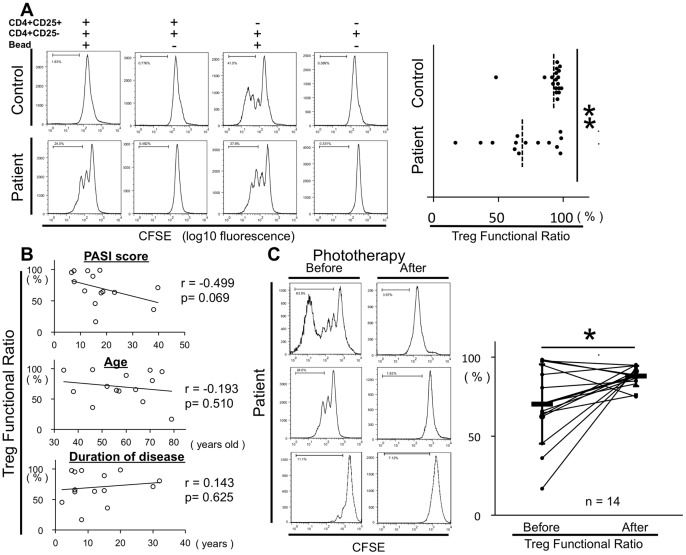
Photo(chemo)therapy restores dysfunctional Treg in patients with psoriasis.(A) CD4+T cells were separated with magnetic beads as CD25+T cells or CD25− T cells. CD4+ CD25− T cells were labeled with CFSE, and activated with anti-CD3, CD28 beads for 4 days, with or without CD4+ CD25+T cells (Treg) (CD4+ CD25− T cells : CD4+ CD25+T cells = 2×105 : 1×103). FACS data for a typical patient and control are presented. Cells were gated on CD4+T cells. Treg did not suppress CD4+ CD25− T cell proliferation in patients (lower panels) as effectively as in controls (upper panels). The ability of Treg to suppress the proliferation was referred to as the Treg Functional Ratio, determined by comparing the rate of the proliferated CD4+CD25− T cells with and without CD4+CD25+T cells (Figure S1). Summarized data of Treg Functional Ratio in the patients (n = 14) and in the age-matched controls (n = 11) are shown. *p<0.05 and **p<0.01. Horizontal bar indicates mean value. (B) Correlation coefficient between Treg Functional Ratio and PASI score, age or disease duration (n = 14). (C) A Treg functional assay was performed with PBMC in patients before and after photochemotherapy. Histograms of the proliferated CD4+CD25− T cells with CD4+CD25+T cells in three typical patients before and after treatment are shown. Summarized data of Treg Functional Ratio in the patients (n = 14) are shown. Treg Functional ratio in patients is restored to almost normal levels. *p<0.05.